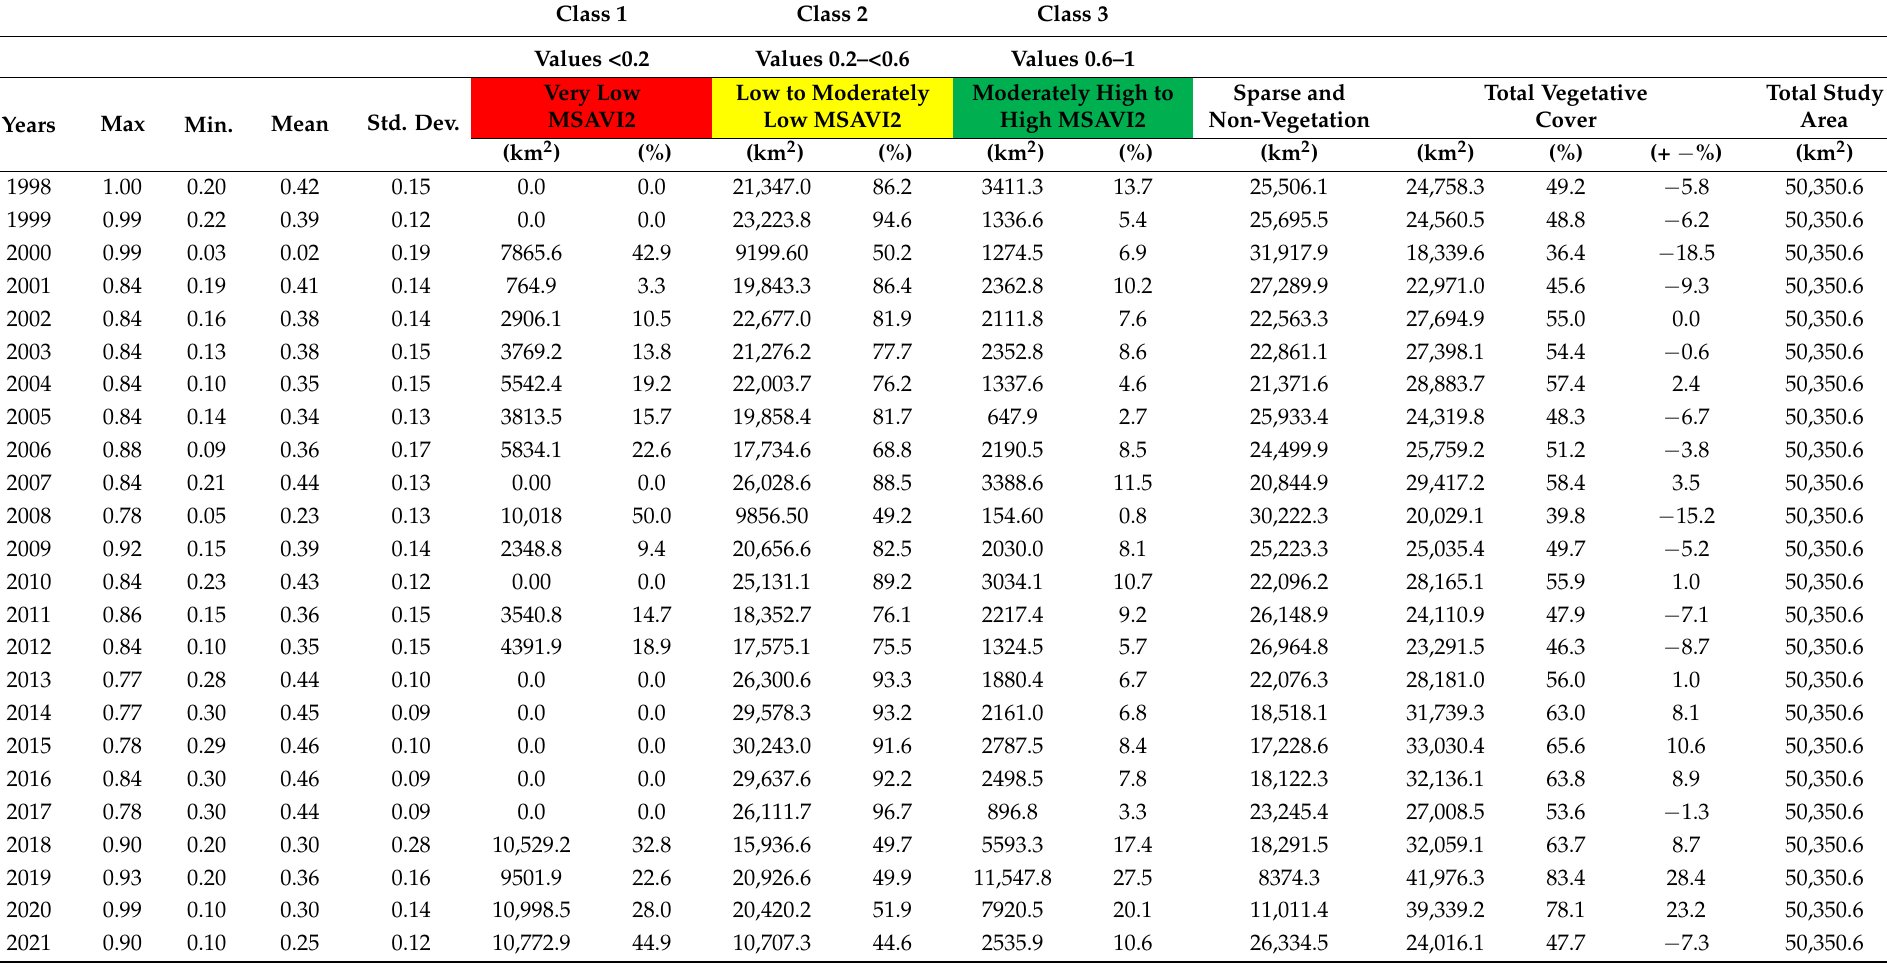
Table 2. The max, min, mean, std. dev. of MSAVI2 values and the area of vegetative cover and the MSAVI2—based vegetation density classes in the KRI from 1998 to